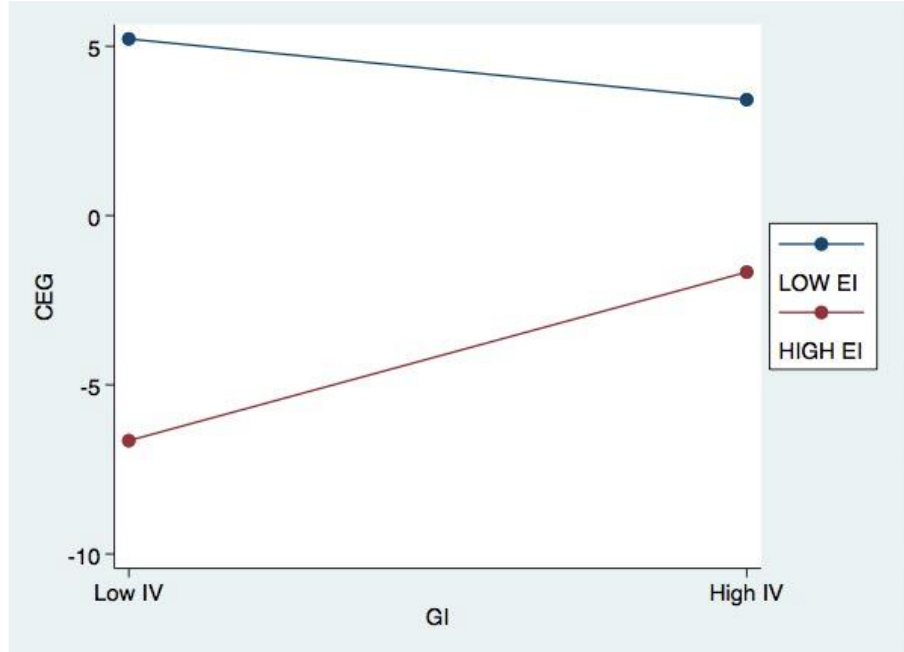
Figure 2. Effects of EI on the relationship between EU and CEG.